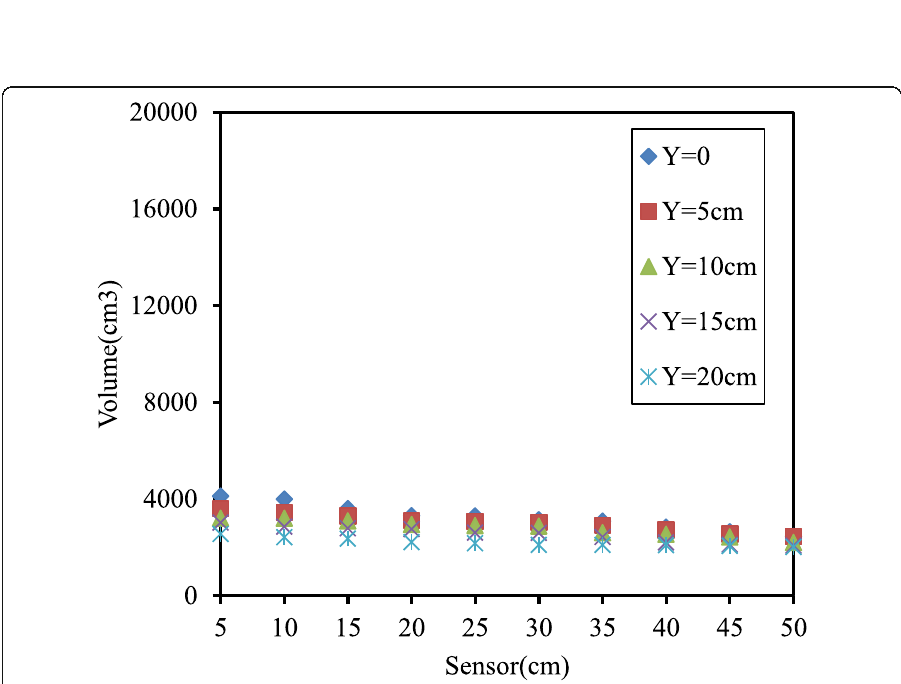
Fig. 24 Volume analysis for non-cavity